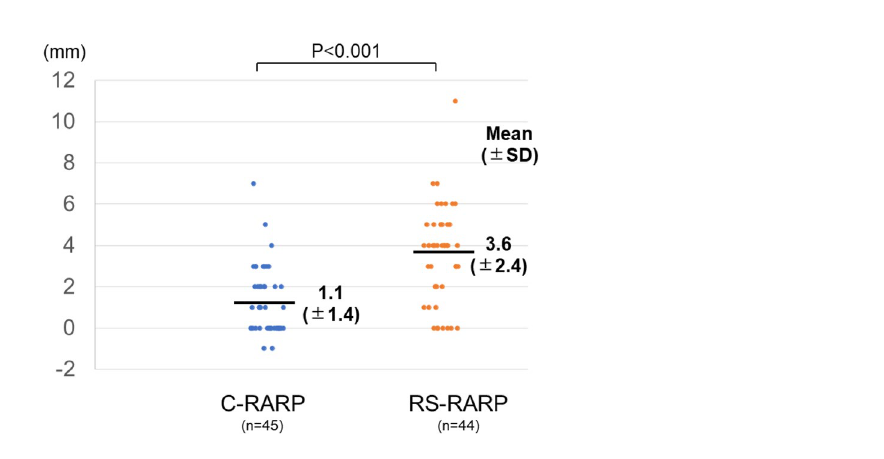
Figure 5. Comparison of the compression distances defined as the thickness of the external urethral sphincter at rest minus the thickness during abdominal pressure after conventional robot-assisted radical prostatectomy (C-RARP) and Retzius-sparing RARP